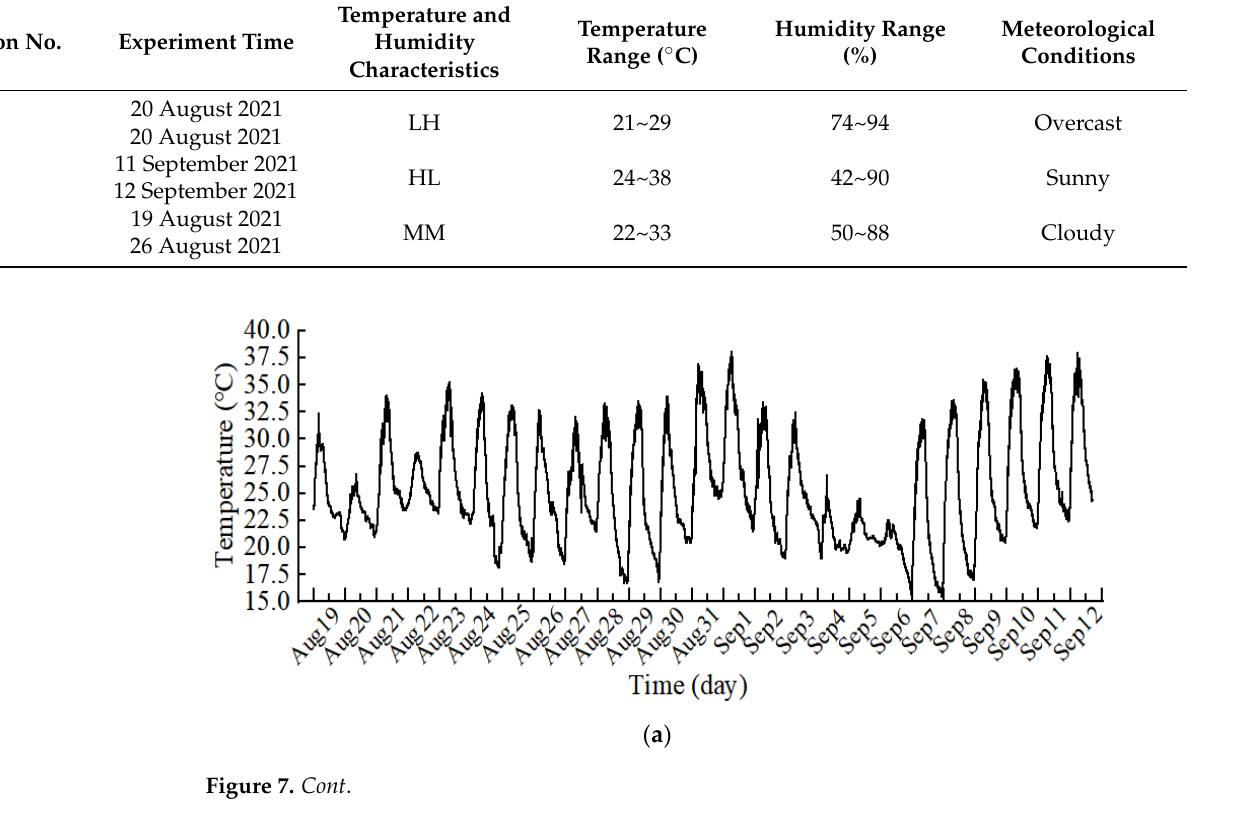
Table 4. Accuracy and uncertainty of measured parameters.